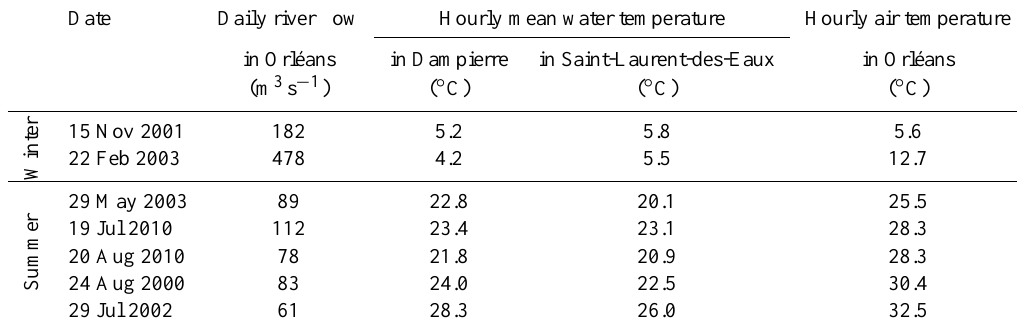
Table 1. Loire River temperature, air temperature and river flow rate at the date and time satellite images were taken. Date Daily river flow Hourly mean water temperature Hourly air temperature in Orléans in Dampierre in Saint-Laurent-des-Eaux in